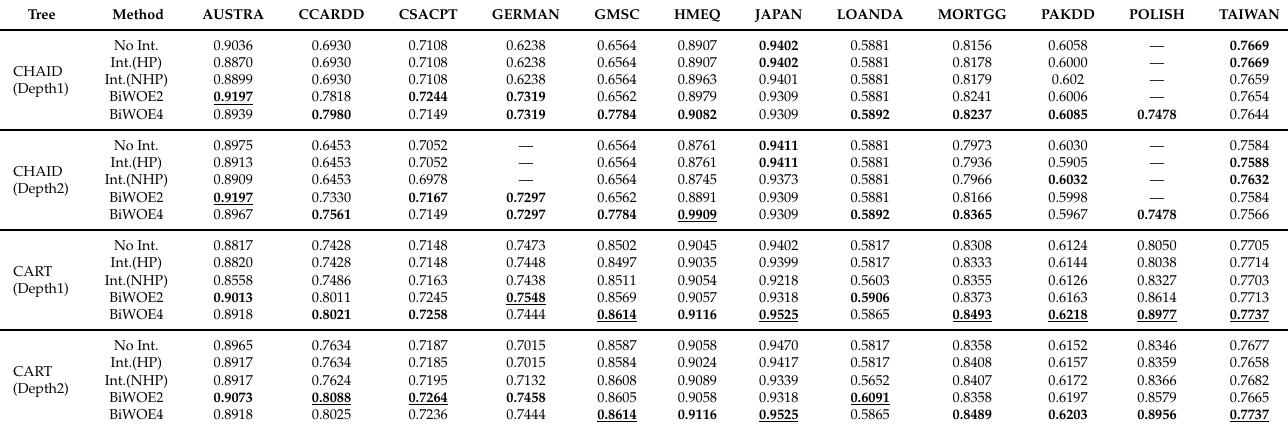
Table 9. AUC test performances by dataset for each combination of tree growing algorithm, depth of the trees, and method. Tree